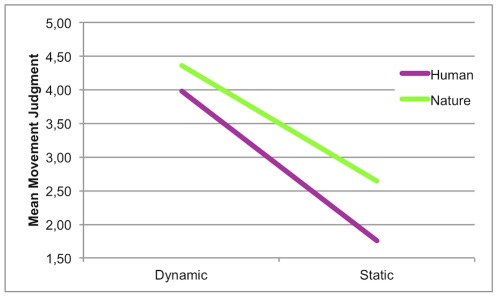
Movement ratings in Content×Dynamism.